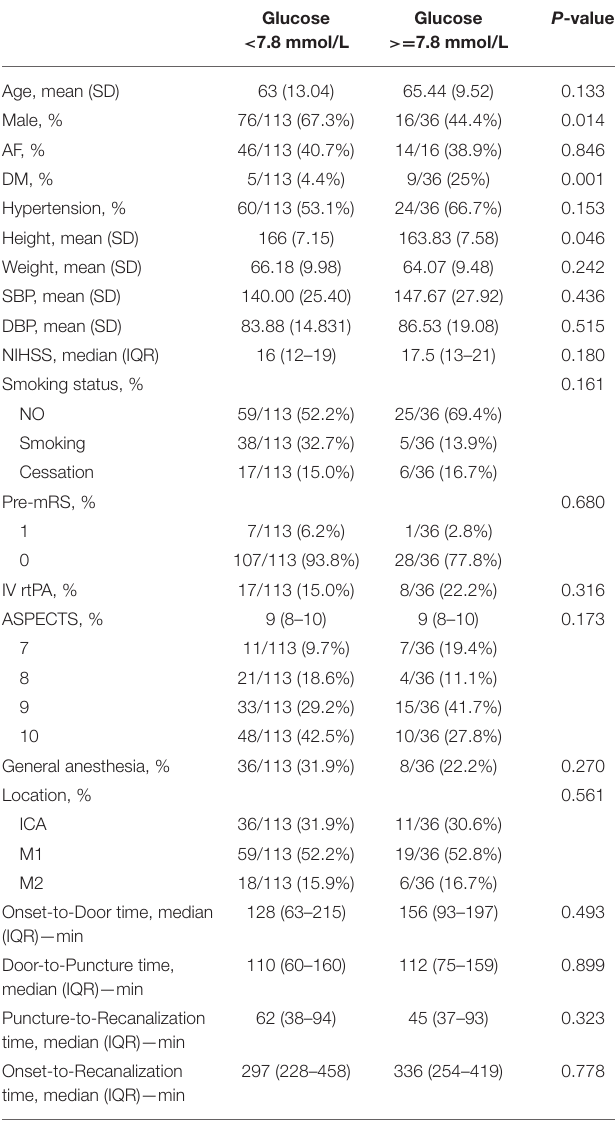
TABLE 2 | Baseline and treatment characteristics for patients with different admission hyperglycemia state.